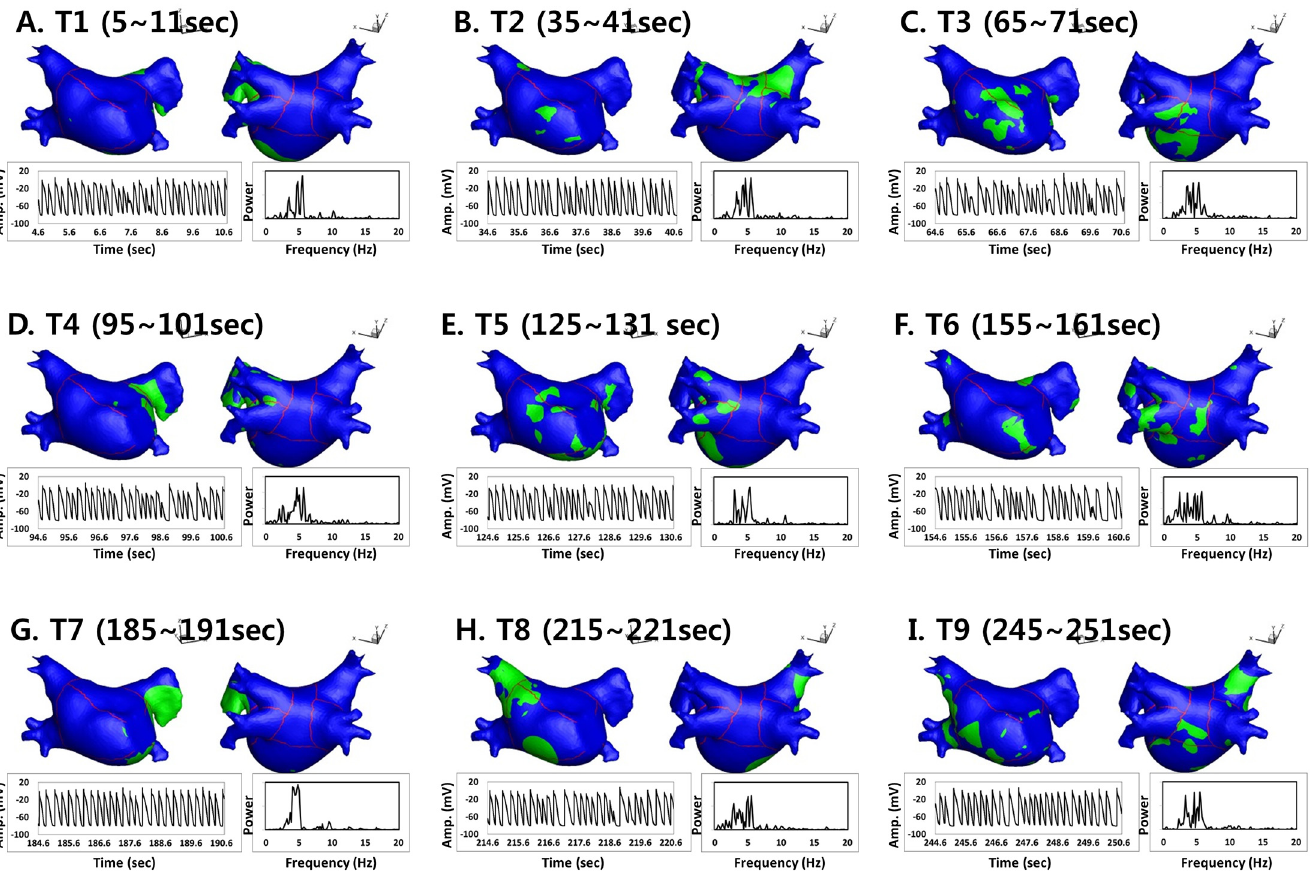
Fig 2. Spatiotemporal changes of the high DF area ( (cid:3) the highest 10% DF region) in each analysis period (T1 – T9). AP tracing was acquired at the LA roof top, and the power spectrum of the fast Fourier transform analysis was obtained from the same AP tracing.